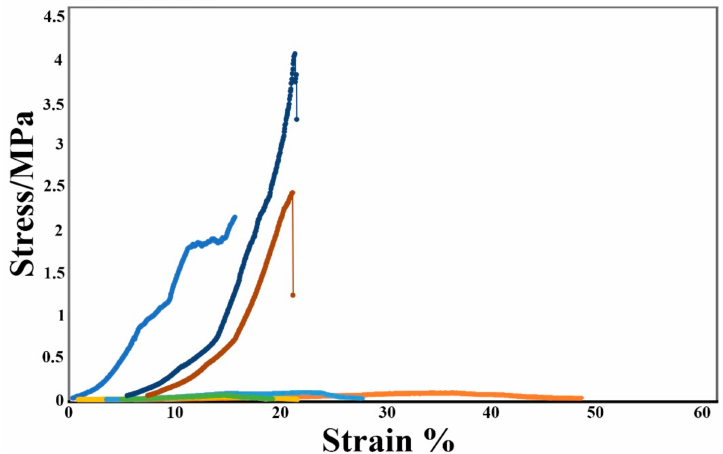
Figure 5. Typical stress-strain curves of as-prepared fibrous